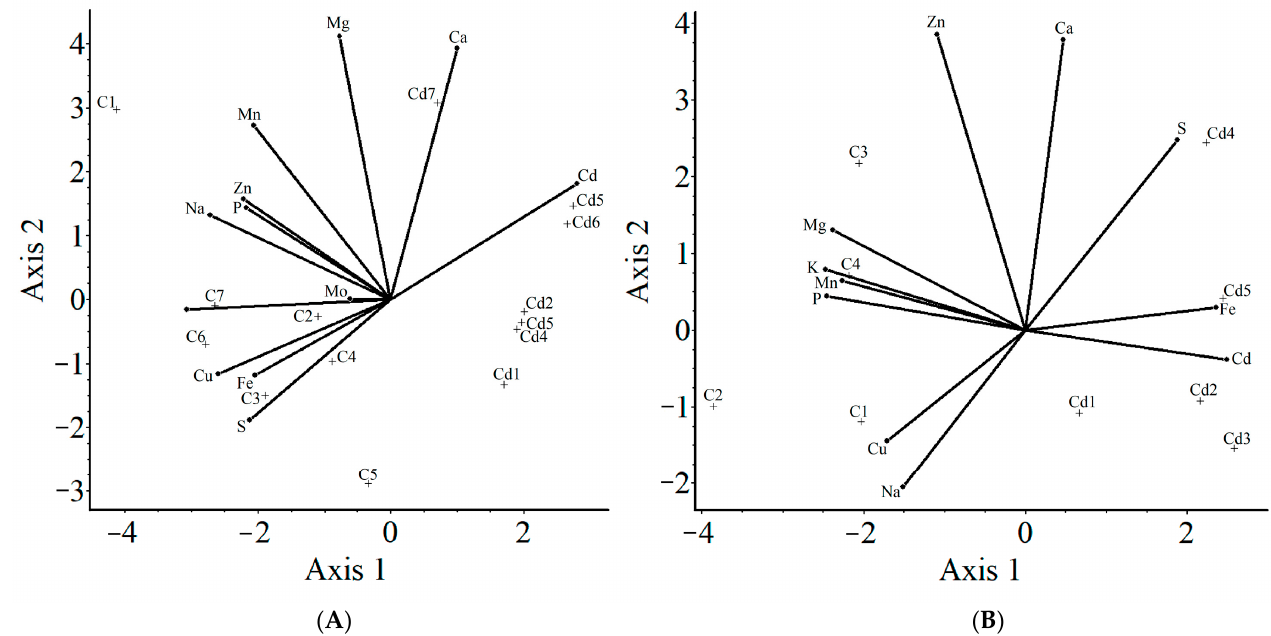
Figure 5. Principal component analysis of mineral uptake pattern in shoot ( A ) and root ( B ) samples of energy grass in Ctrl and Cd treatment. C refers to Ctrl.